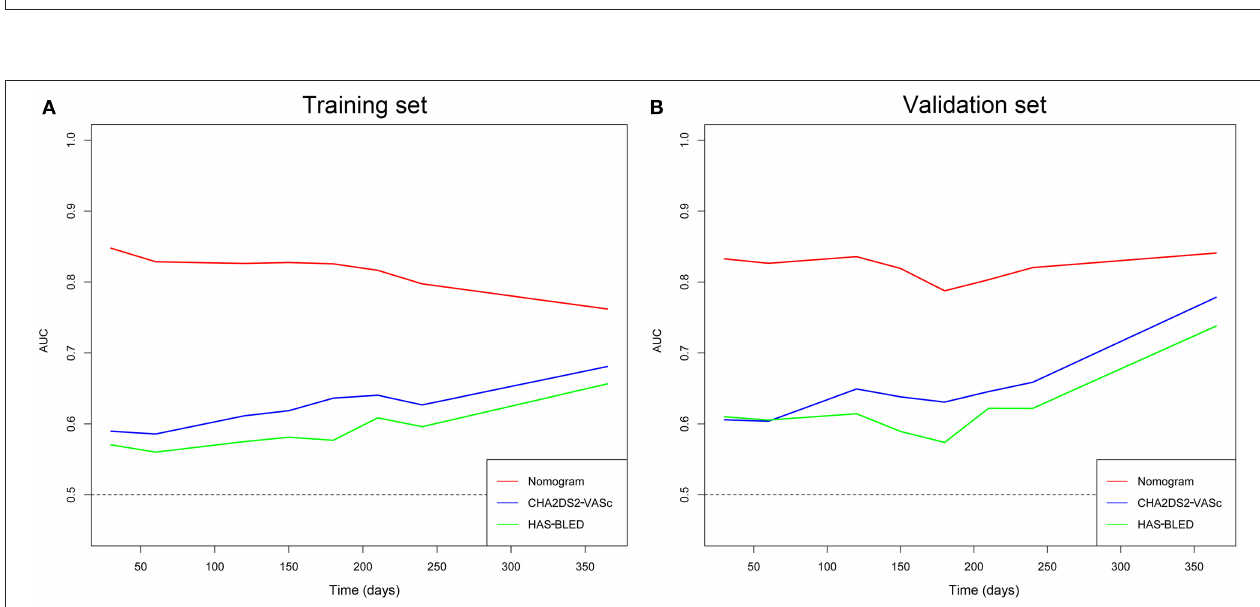
FIGURE 4 | Nomogram for predicting 30-, 180-, and 365-day survival probabilities for AF patients. To calculate patient survival probabilities, obtain points for each covariate value by dropping a vertical line from the points axis to the value of each covariate, calculate the total points obtained from all eight covariate values, and then drop a vertical line from the total points axis to locate the associated 30-, 180-, or 365-day survival probability. KET, urine ketone body; BUN, blood urea nitrogen; CHE, cholinesterase; MAO, monoamine oxidase.